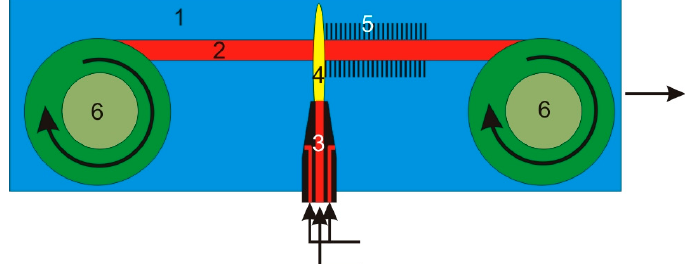
Figure 6. Schematic diagram of the continuous microwave plasma system for CNT synthesis where: 1—reactor space; 2—substrate-metal strip; 3—microwave plasma head; 4—microwave plasma torch; 5—CNTs; 6—cassettes to move the metal substrate.